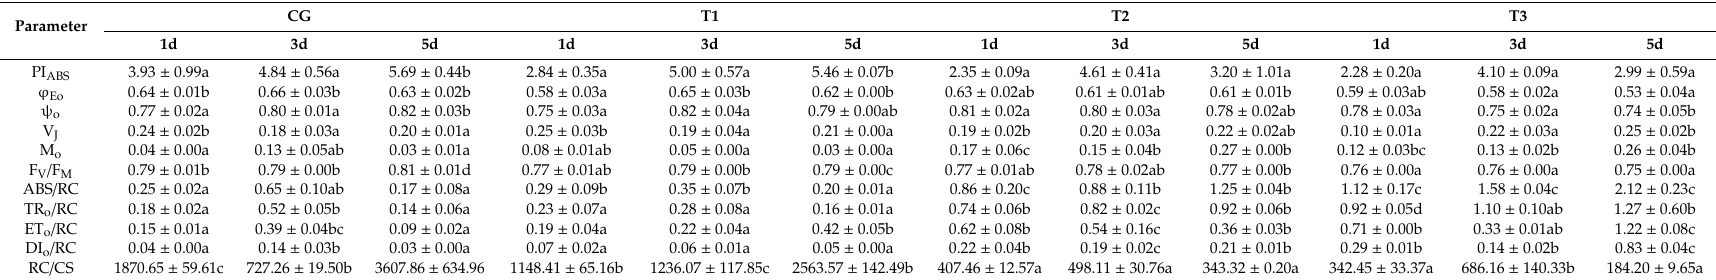
Di ff erent letters at the same day column for the parameters from di ff erent treatment group represent significant di ff erence at the 0.05 significance level (Tukey HSD), mean values ± SD, n =